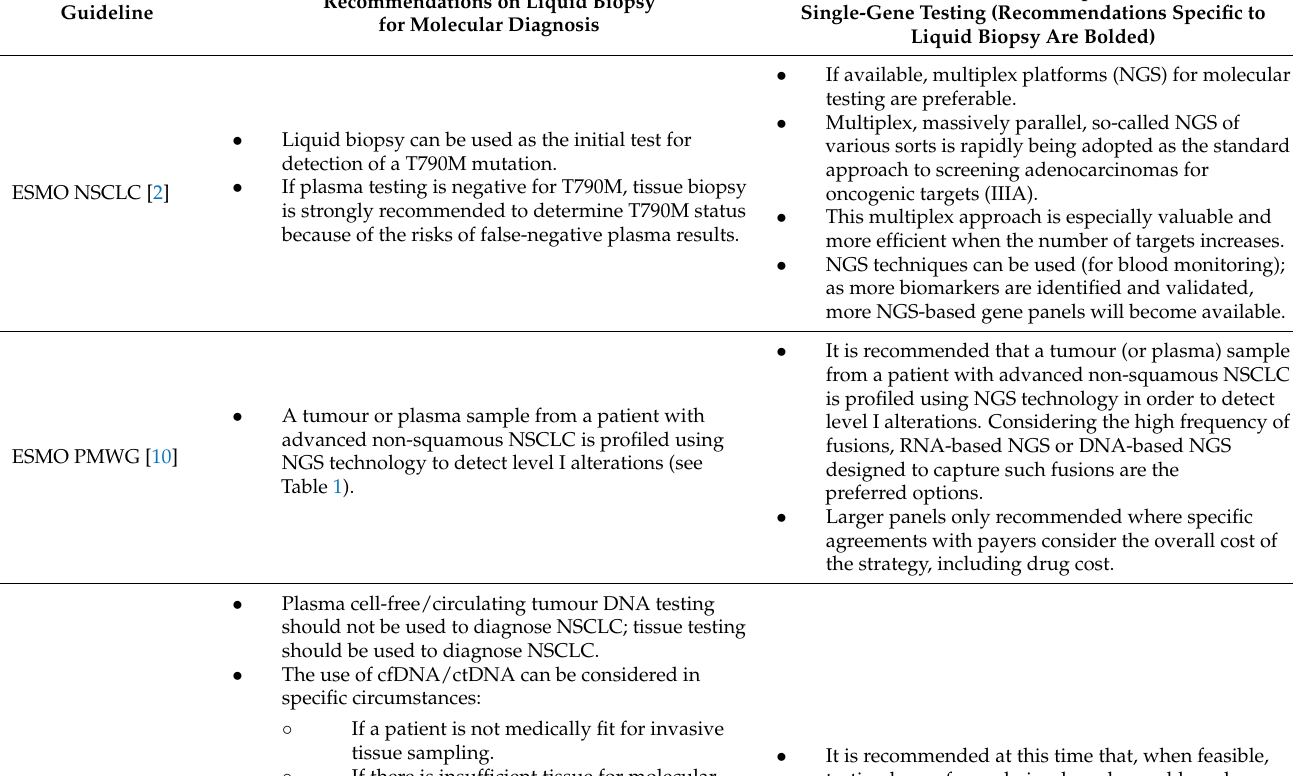
Table 4. Comparison between European and U.S. clinical guidelines on liquid biopsy for molecular diagnosis in NSCLC. Recommendations on Multiplex Panel versus Recommendations on Liquid Biopsy Guideline Single-Gene Testing (Recommendations Specific to for Molecular Diagnosis Liquid Biopsy Are